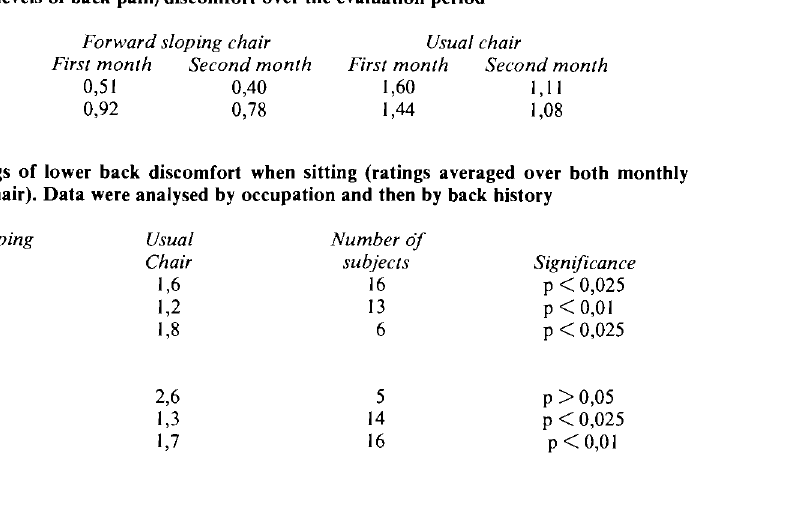
Table 2. Mean levels of back pain/discomfort over the evaluation period